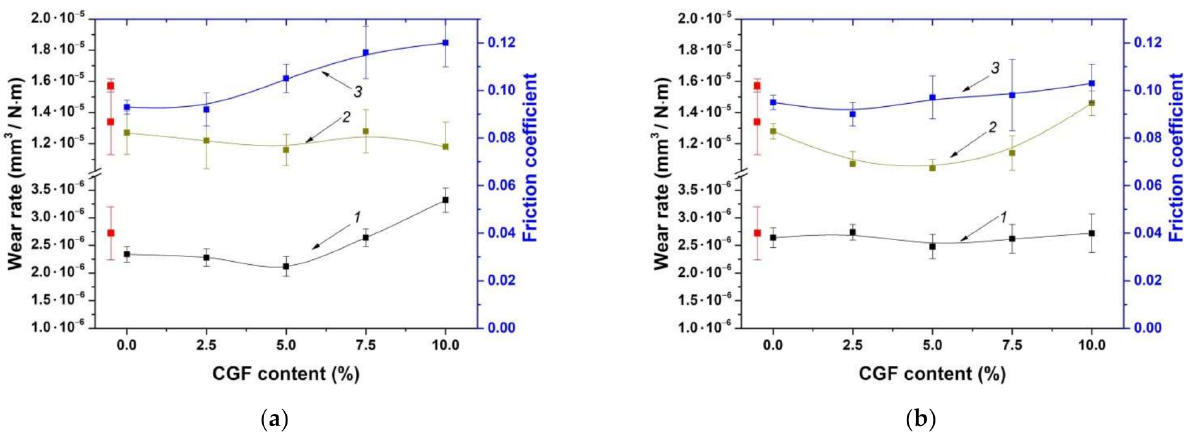
Figure 5. Wear rates according to the ‘pin-on-disk’ (curve 1, 5 N · 0.3 m/s) and ‘block-on-ring’ (curve 2, 60 N · 0.3 m/s) schemes as well as the average friction coefficients (curve 3) versus filler weight fraction: HC-PM ( a ), HC-TSE ( b ).